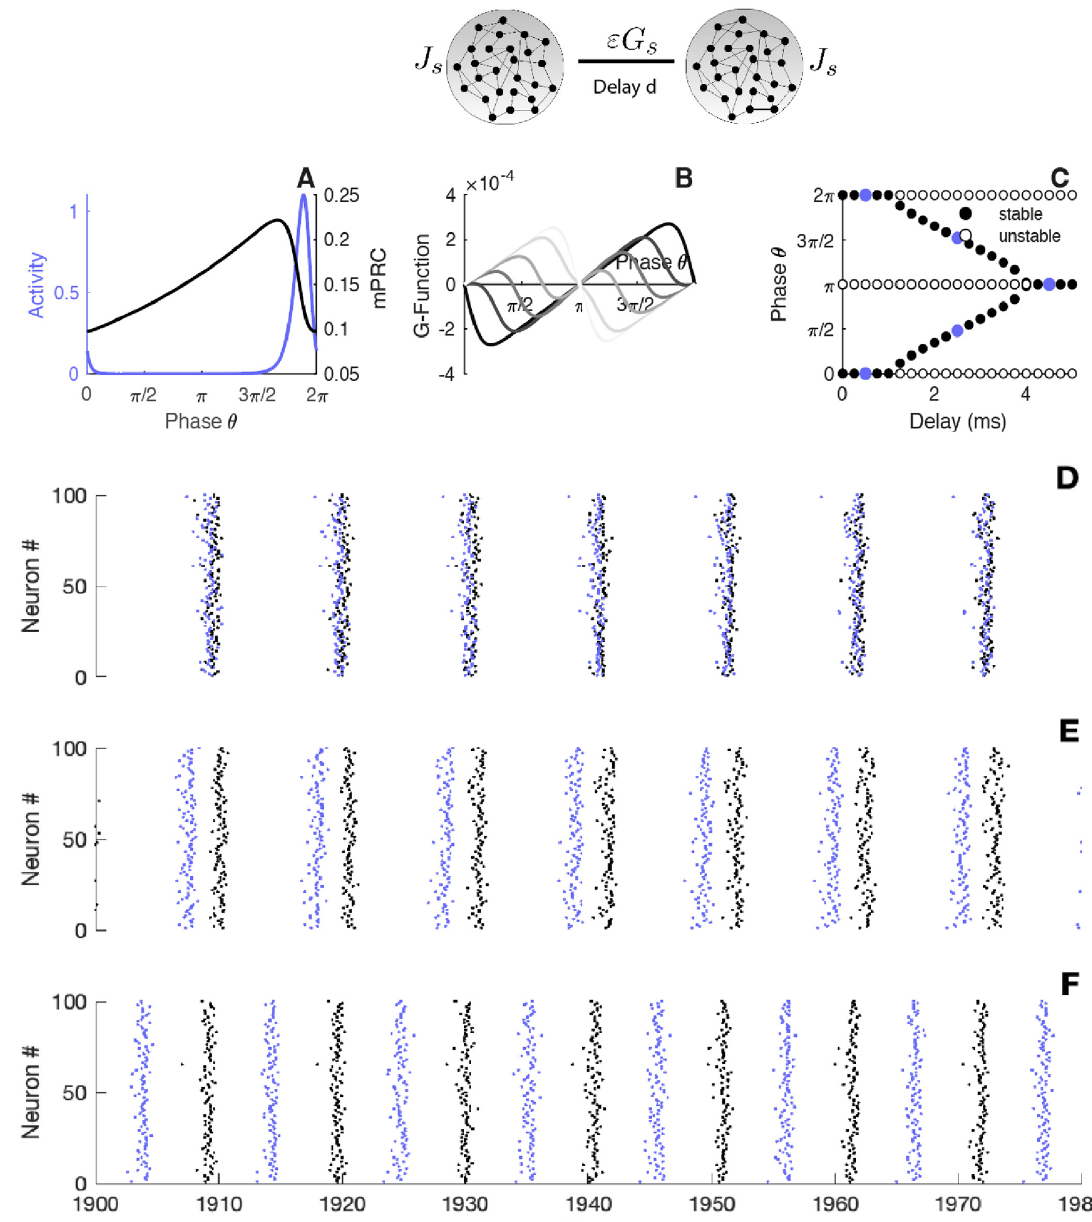
Fig 5. Locking modes of interacting circuits. Top panel: illustration of the two circuits in interaction, ε G strength across networks, J s represents the internal coupling strength, d represents the delay across circuits. A) The panel displays one period of the activity as well as the mPRC. B) The G -function for different parameter values of the delay, dark/light colors correspond to small/large delay. C) Zeros of the G -function for different parameter values of the delays. The circles are filled for stable fixed point and empty for the unstable points. D-E-F) Raster plot of the spiking activity of the two neural networks, black dots indicate the spike timing of the first network, coloured dots indicate the spike timing of the second network. Parameters: S ( h , r ) = exp( h ) H ( r − T T ref ) / τ )), I ext = 2 mV , T ref = 10 ms , τ s = 10 ms , τ = 5 ms , J s = 15 mV . ms , N = 5000 G s = 0.2 mV . ms , Δ t = 0.005 ms for all the panels and D) d = 0.5 ms , E) d = 2.5 ms , F) d = 4.5 ms